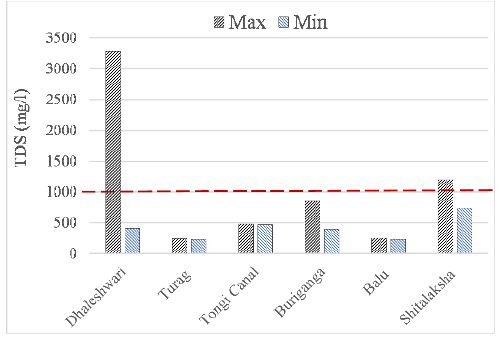
Figure 4 . Max m vs. Min m Concentration of TDS for the peripheral rivers of Dhaka with WHO standards in dotted lines (1000 mg/L).